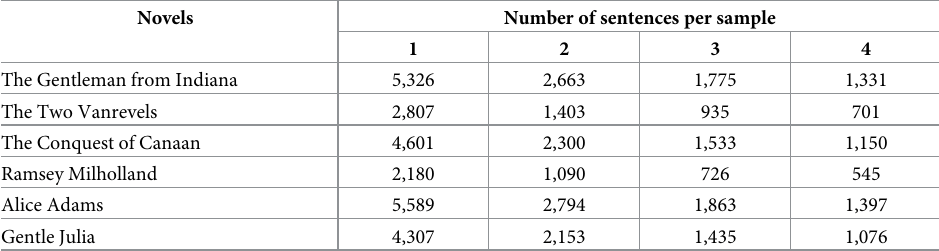
Table 3. Sentences in novels of